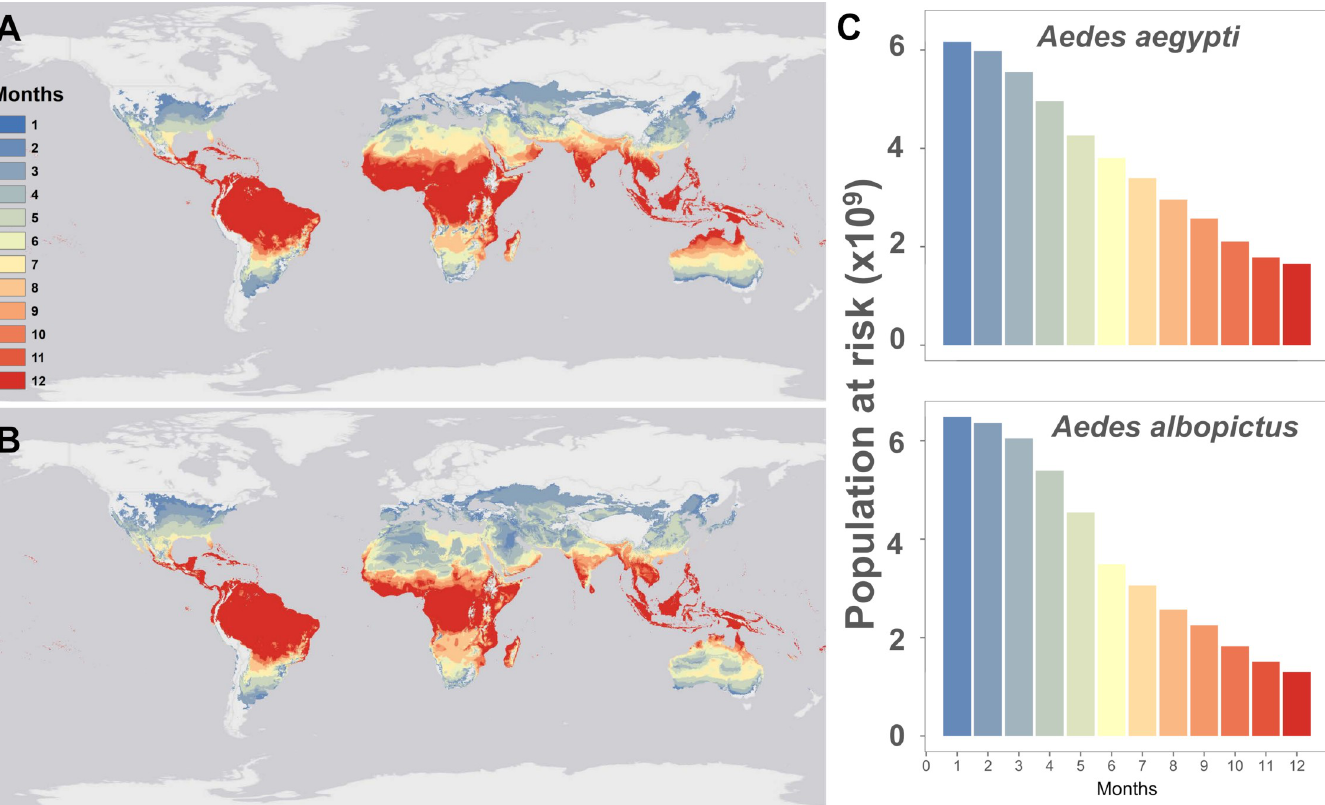
Fig 1. Mapping current temperature suitability for transmission. Maps of current monthly suitability based on mean temperatures using a temperature suitability threshold determined by the posterior probability that scaled R 0 > 0 is 97.5% for (a) Aedes aegypti and (b) Ae . albopictus , and (c) the number of people at risk (in billions) as a function of their months of exposure for Ae . aegypti and Ae . albopictus